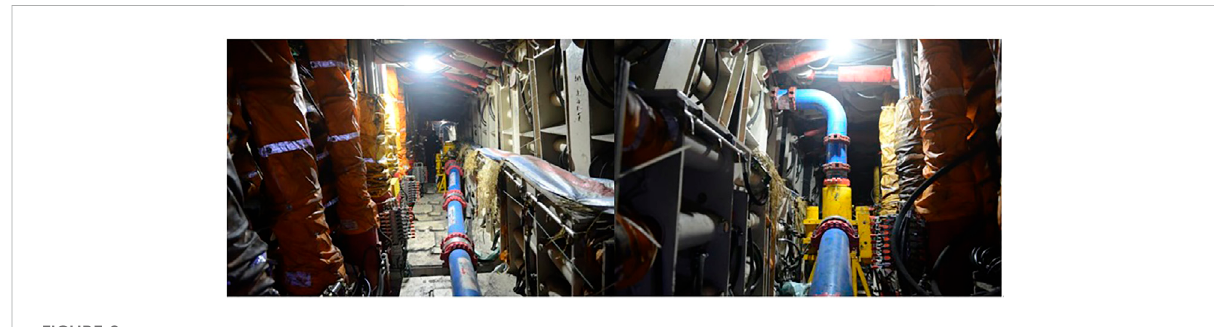
FIGURE 8 Site layout of the paste fi lling pipeline.